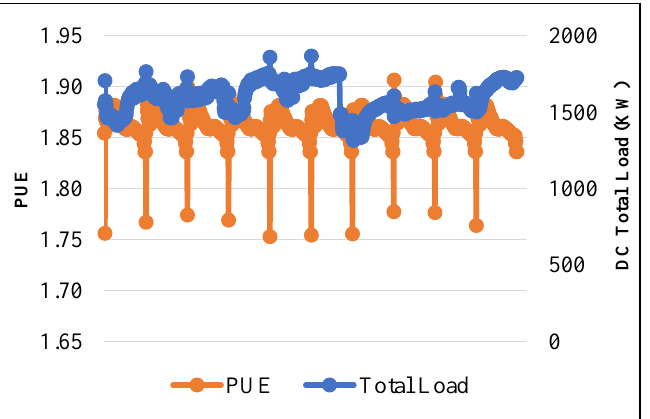
Figure 10. Actual data PUE vs DC total